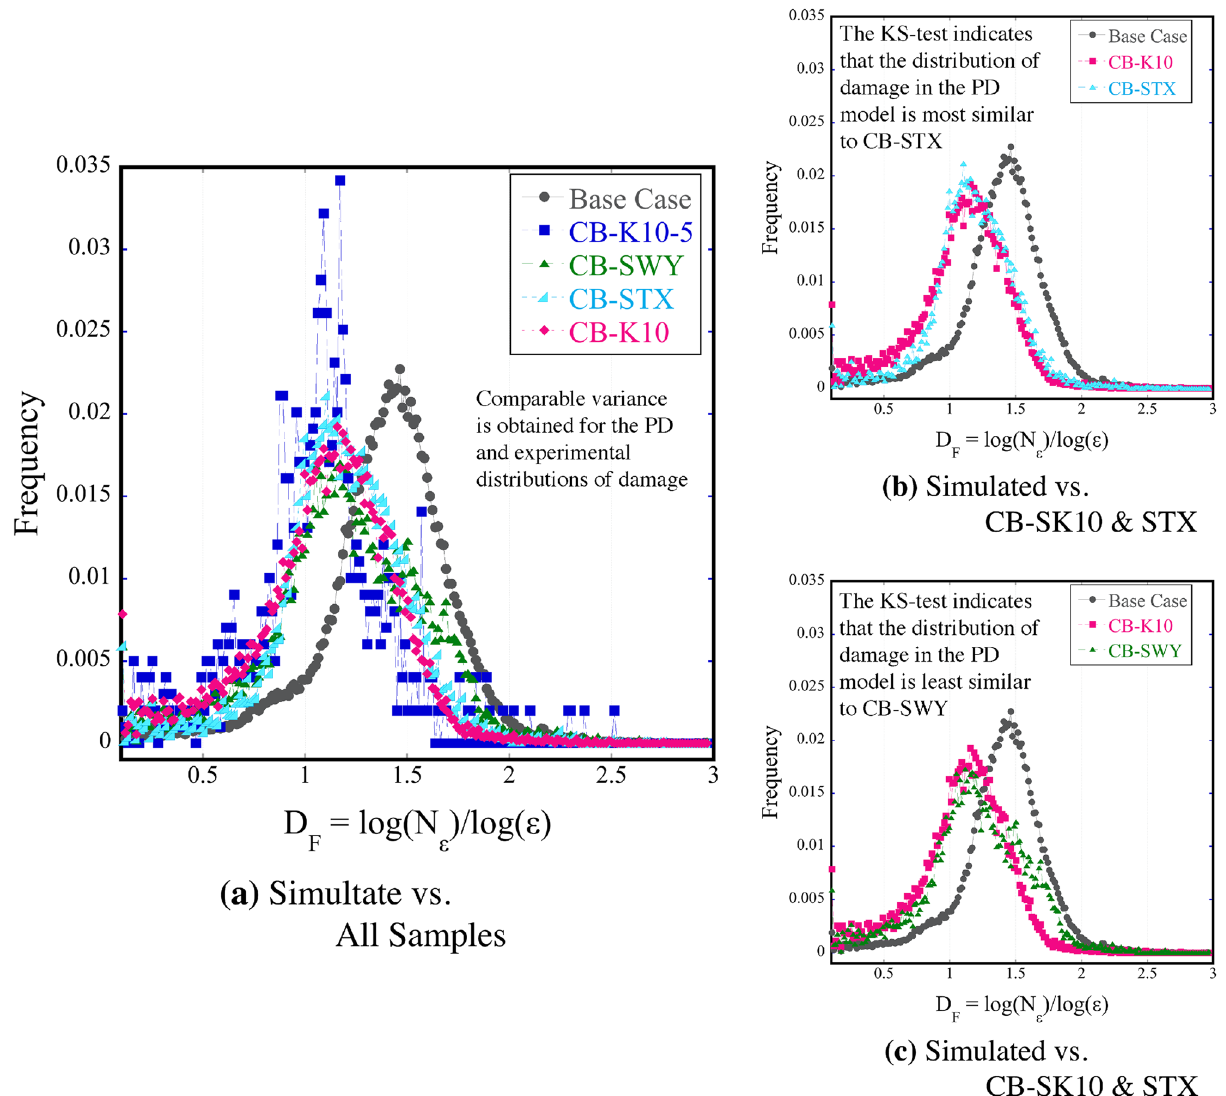
Figure 10. The mean distribution of the fractal dimension D F , is a measure of the change in crack density with a change in scale estimated for each sample. Here a comparison ( a ) of the PD data versus the damage distribution in all experimental samples is plotted, along with ( b ) histograms for the PD data, and experimental samples CB-K10 and CB-STX, and ( c ) the distributions for Cb-SK10, Cb-SWY, and the PD data.